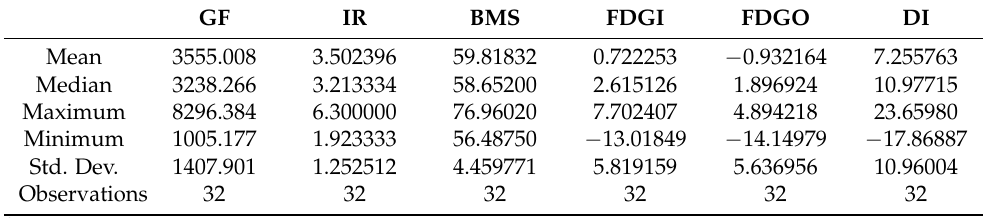
Table 4. The result of descriptive statistics.